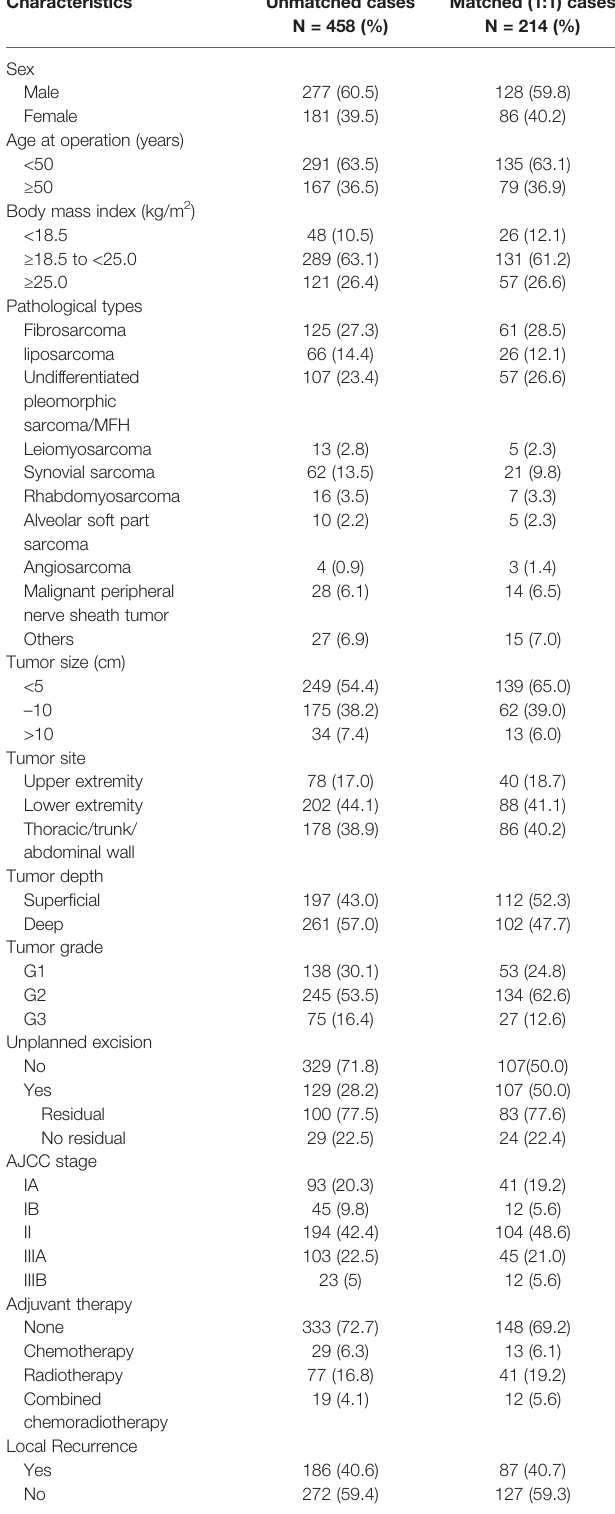
TABLE 1 | Baseline clinicopathological characteristics before and after propensity score matching.